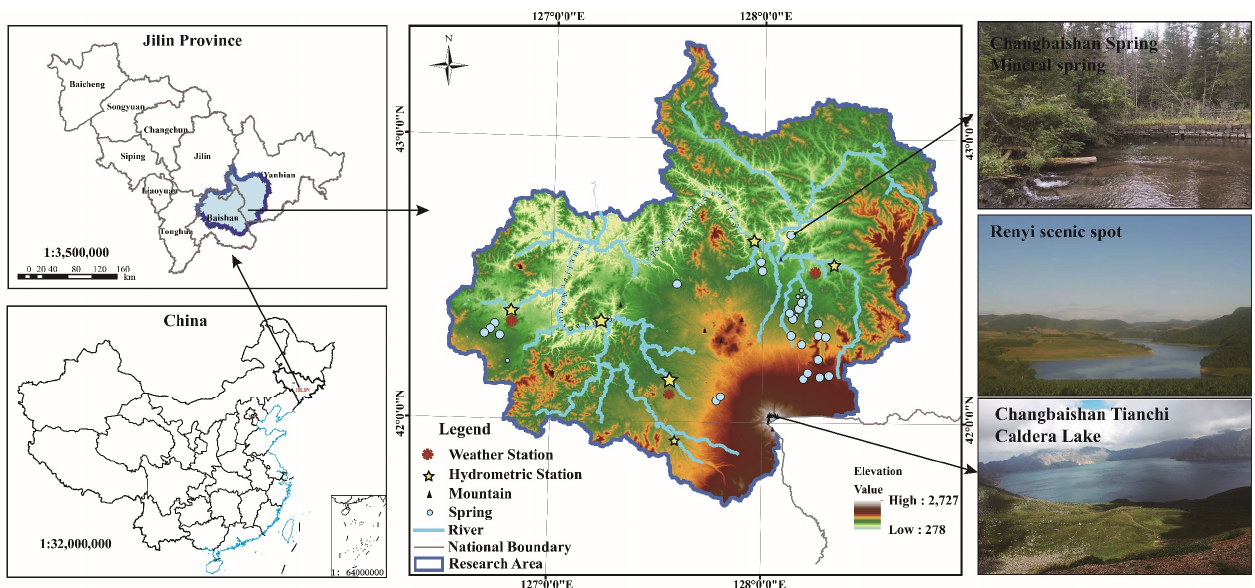
Figure 2. The location of the research area. DEM is downloaded from http://www.gscloud.cn/sources/accessdata/310?pid=302, accessed on 5 June 2021. The map of China was downloaded from http://bzdt.ch.mnr.gov.cn/, accessed on 5 June 2021, GS (2019)1676. Table 4. Data sources and a detailed explanation of their